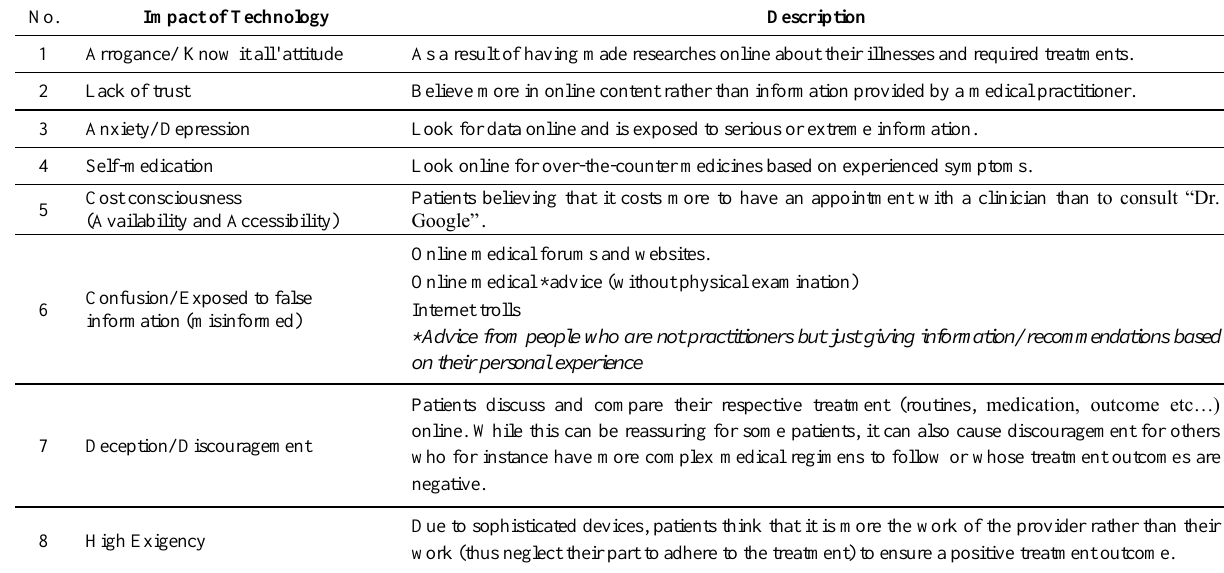
Table 2. Main factors that were found to affect patient